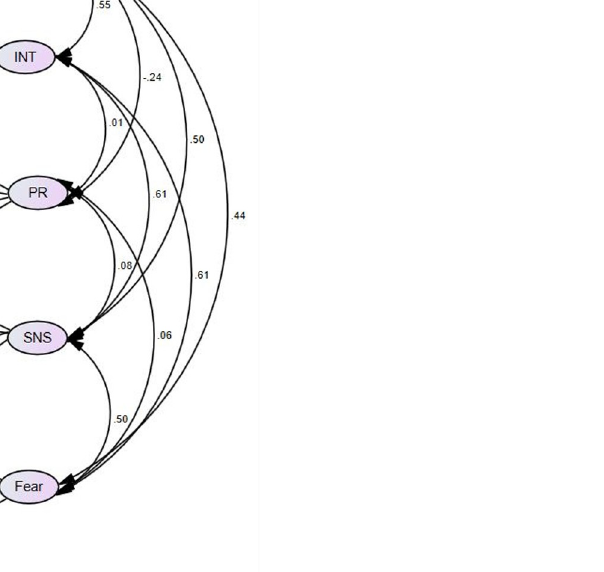
Fig 2. Confirmatory factor analysis